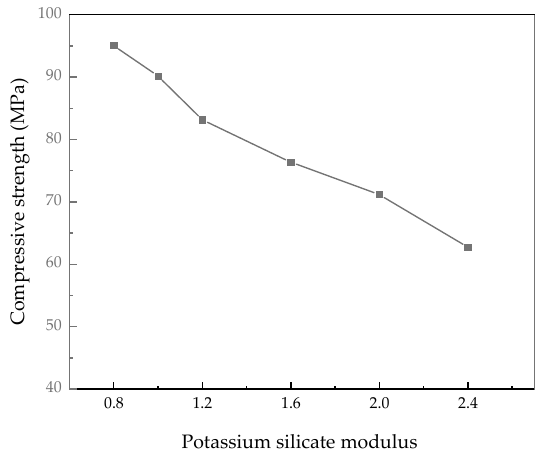
Figure 5. The compressive strength of alkali-activated BFS with different modulus.